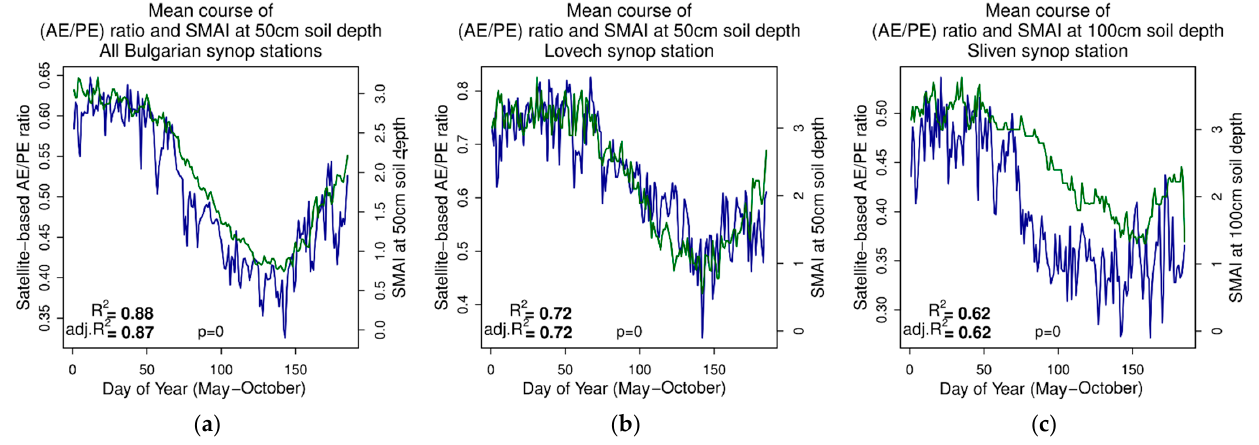
Figure 9. Comparison of time series (May–October) for the AE/PE ratio (blue line) based on LSASAF DMET/METREF and SMAI using the SVAT model (green line): ( a ) mean values from 26 synoptic stations in Bulgaria; ( b ) a station in north Bulgaria; ( c ) a station in south Bulgaria. Daily mean values for 2011–2020 were used.